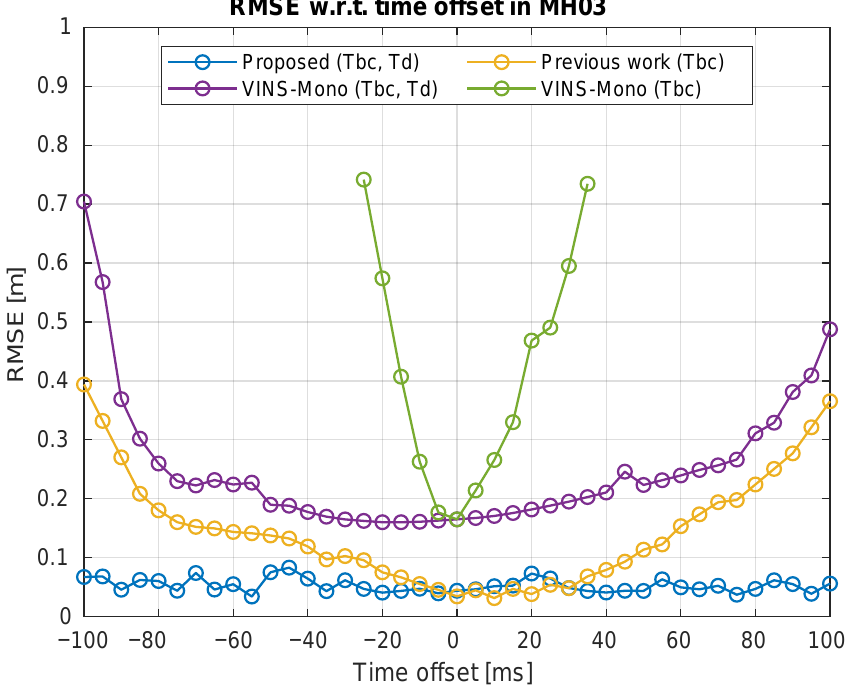
Figure 7. Comparison of the trajectory accuracy under various time offsets using the MH_03 se- quence. The x-axis denotes the various time offsets. The y-axis shows the absolute translational root mean squared error (RMSE) of the estimated trajectory. The curves shown in the figure are, respectively, “Proposed (Tbc, Td)”—Results of the proposed method, which can perform simultane- ous spatial-temporal calibration; “Previous work (Tbc)”—Results of our previous work [36], which only performs spatial calibration; “VINS-Mono (Tbc, Td)”—Results of VINS-Mono [40], which can perform simultaneous spatial-temporal calibration; “VINS-Mono (Tbc)”—Results of VINS-Mono, which only performs spatial calibration. Best viewed in